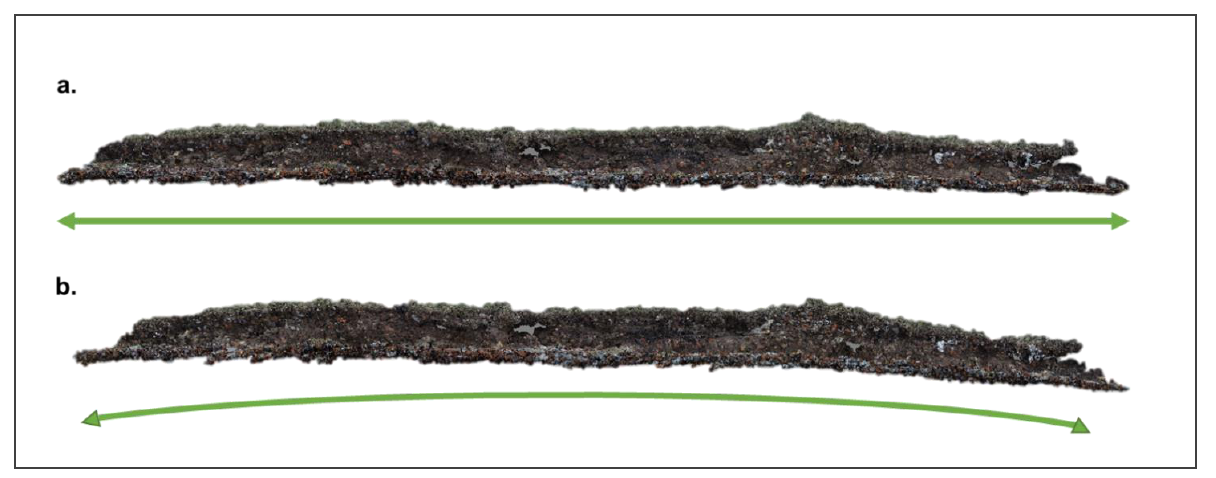
Figure 5. Crosby dense point cloud deformation under differing image alignment parameters. Arrows highlighting the shape of the deformation: ( a ) ‘Medium’ image alignment plus ‘Ultra -h igh’ densification.; ( b ) ‘Highest’ image alignment plus ‘Ultra -h igh’ densification .